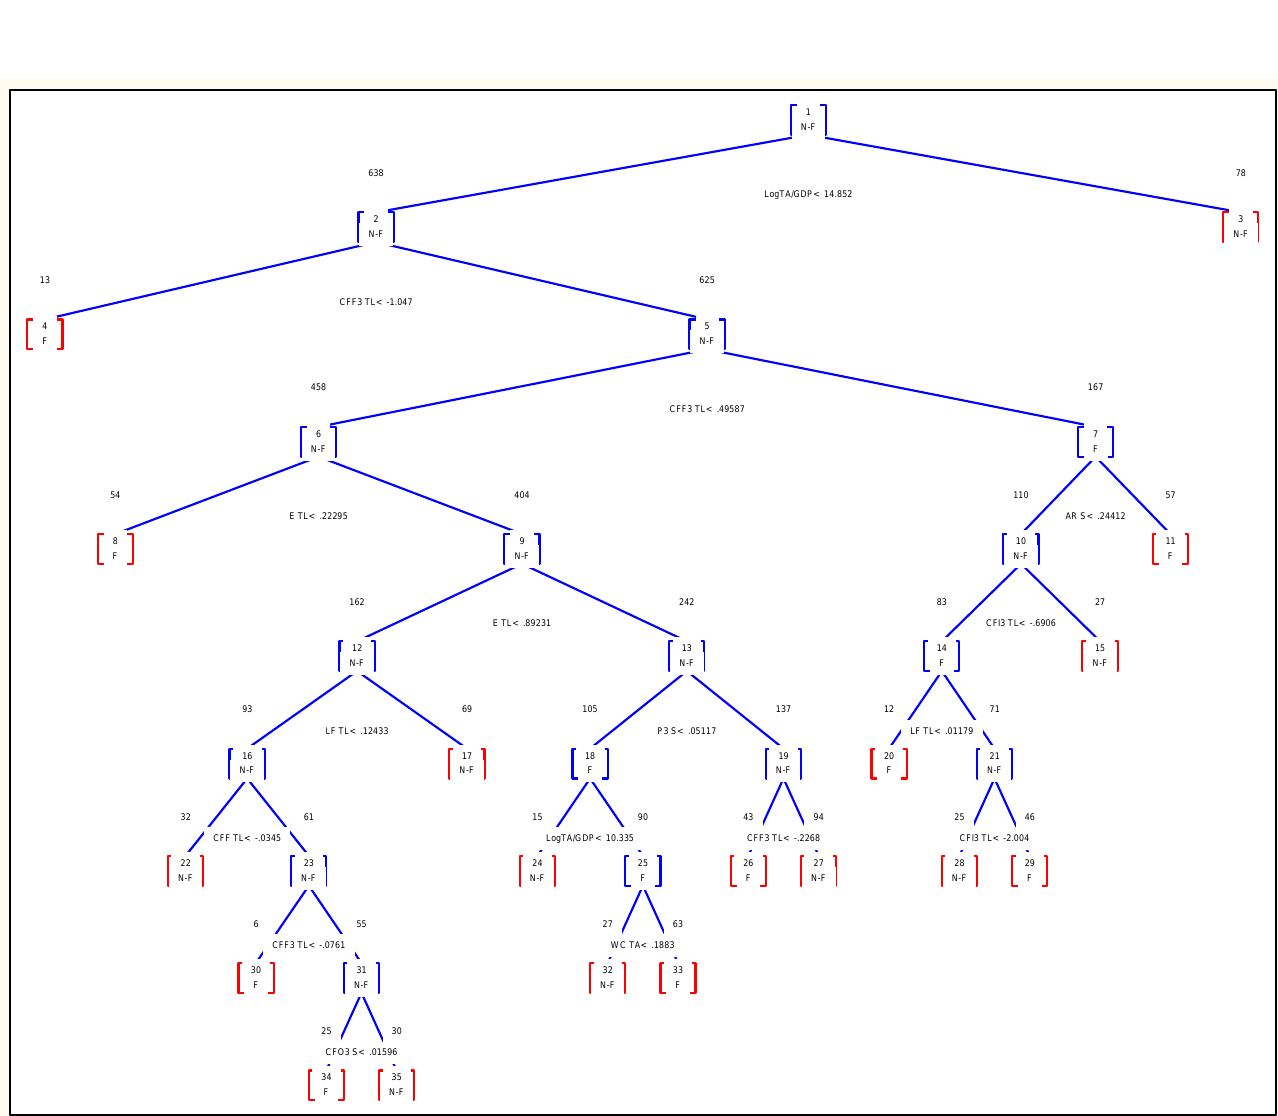
Figure 1: Combined model classification